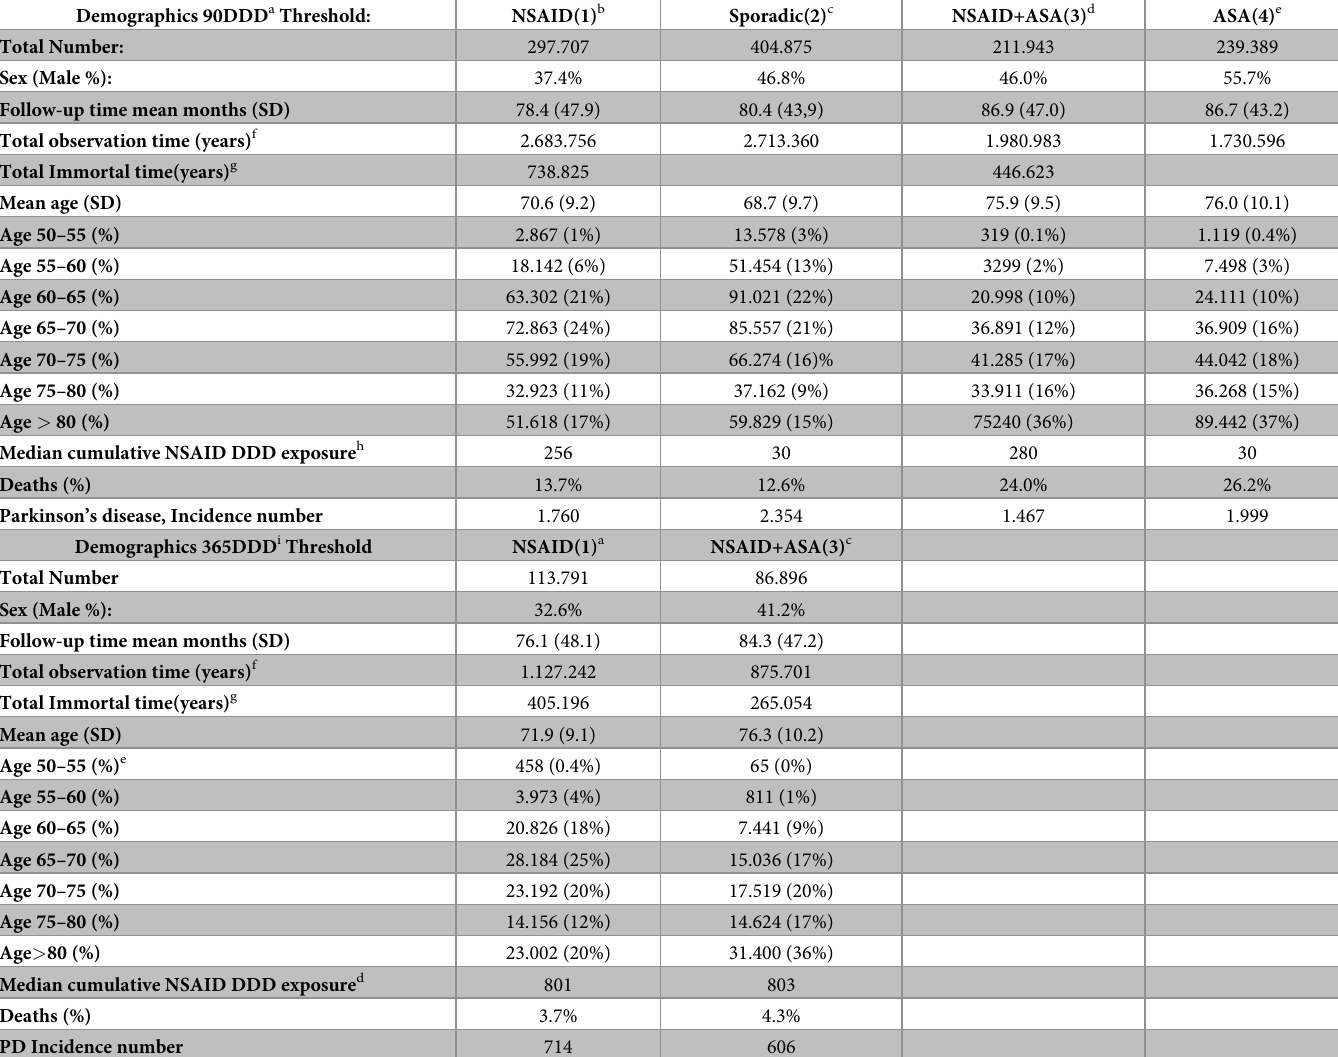
Table 1. Demographics and descriptive statistics for Norwegian Prescription Database groups used in time-dependent Cox regression